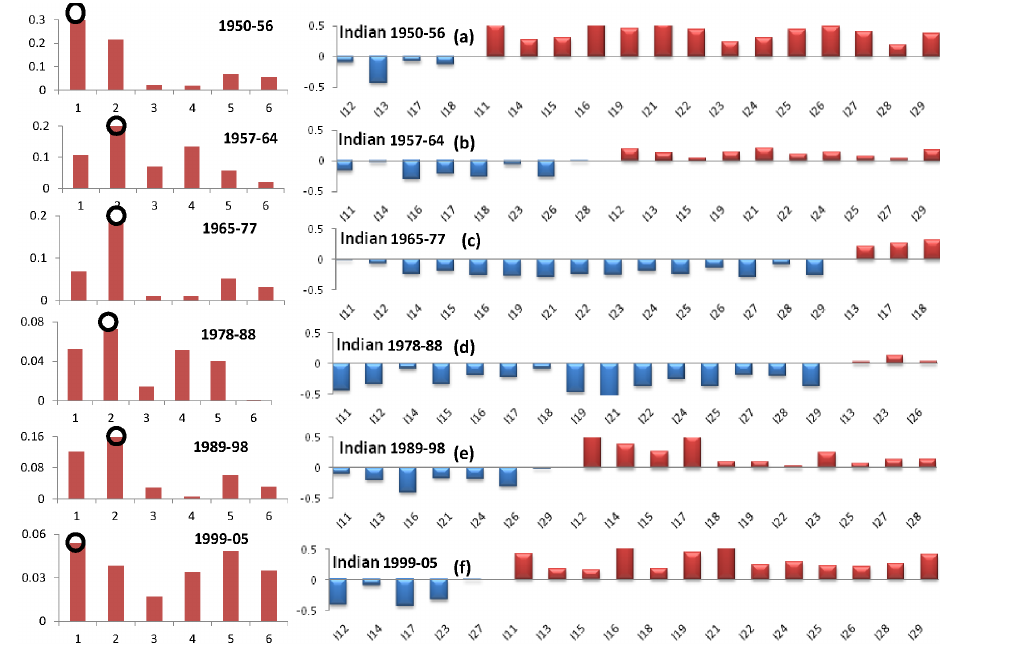
Figure 13. Indian Ocean. Left panel indicates the wave kinetic energy anomaly 1/2( u 2 (n) + v 2 (n) ) with wavenumber ( x axis). Right panel indicates the average normalized fish landings for the Pacific Ocean for each species in the periods coincident with abrupt climate regime shifts. (a) 1950–1956, (b) 1957–1964, (c) 1965–1977, (d) 1978–1988, (e) 1989–1998, and (f) 1999–2005. The x axis code number indicates both geographical ocean sub-region (shown in Fig. 1) and the FAO fish species category. The codes are summarized in Table A1 of the